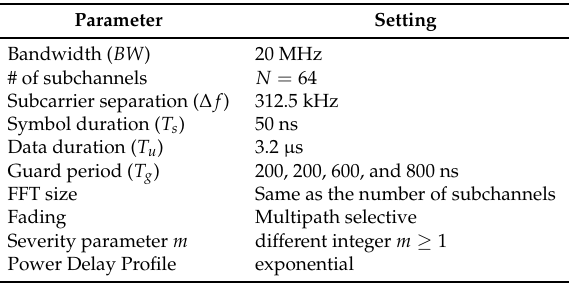
Table 1. Physical parameters for IEEE 802.11a standard.